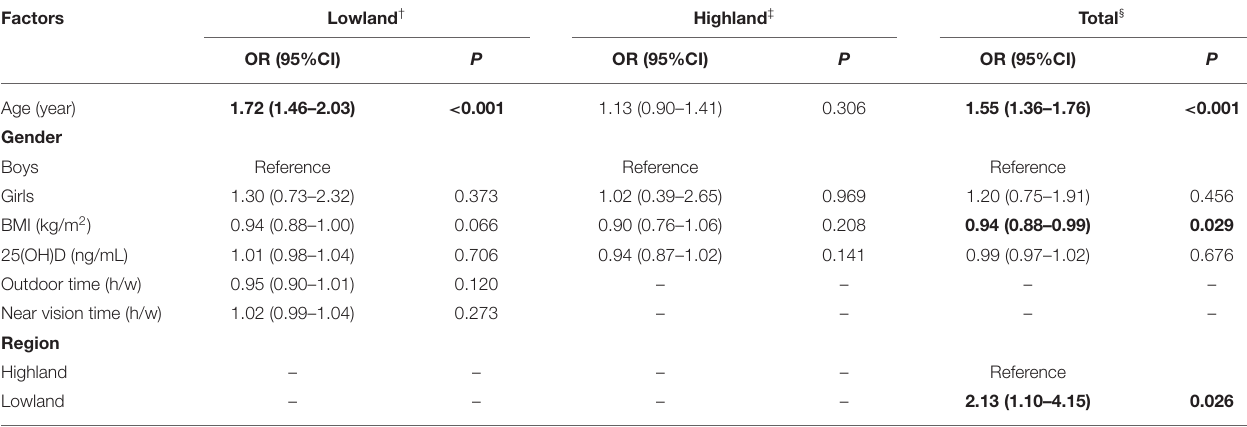
TABLE 2 | Multiple logistic regression of the myopia risk factors in lowland and highland